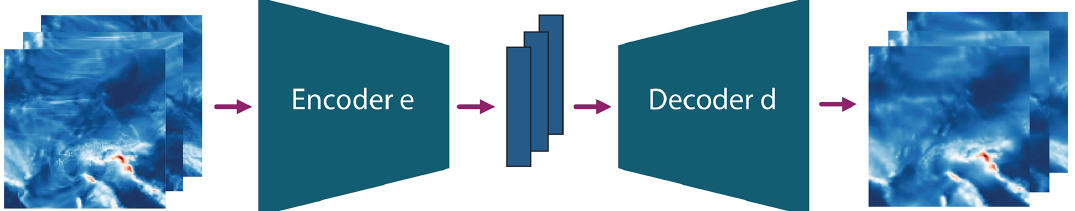
Figure 1. Illustration of a standard autoencoder model: the spatial fields Y are fed to the encoder e which maps them to the latent space variables L (illustrated in blue). These are in turn fed to the decoder d which computes a reconstruction of the input, ˆ Y .